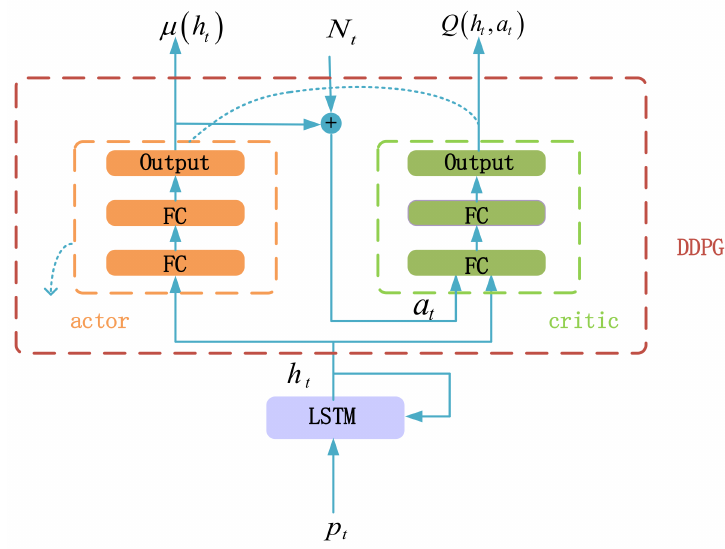
Figure 1. LSTM-DDPG